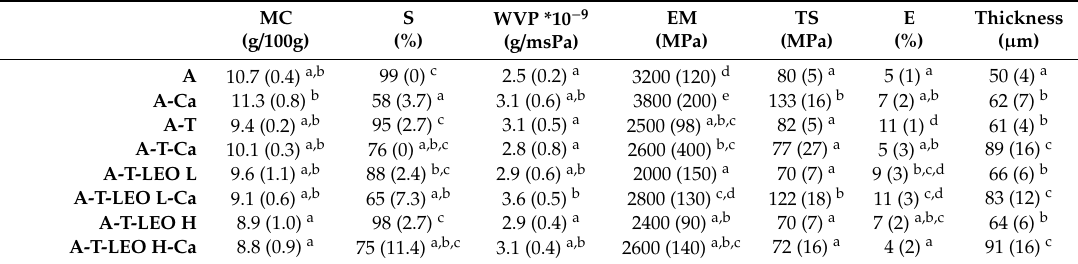
Standard deviation is shown in brackets. Any means in the same column followed by di ff erent letters are significantly di ff erent ( p < 0.05) for LSD